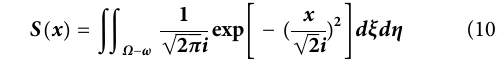
FIGURE 3 GRC curves for two different stable state of tunnel excavated section.